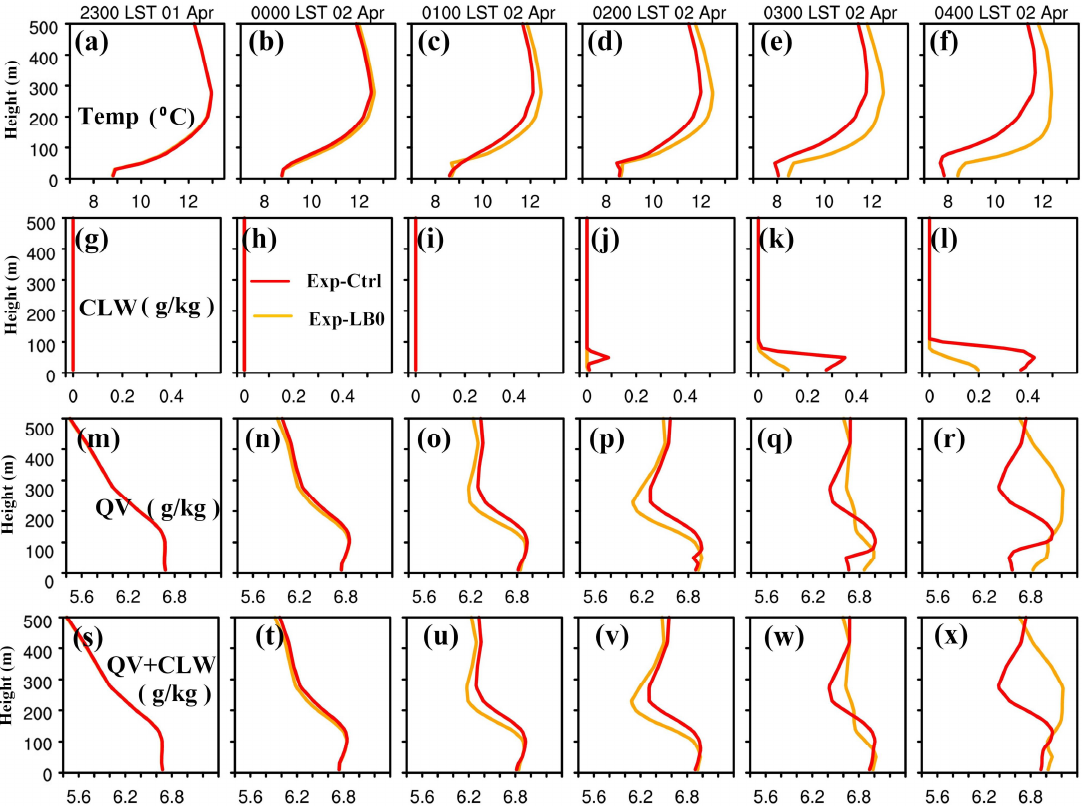
Figure 13. Vertical profiles of air temperature (Temp; ( a – f )), cloud liquid water (CLW; ( g – l )), water vapor (Qv; ( m – r )), and the sum of CLW and Qv (( s – x )) from 2300 LST 1 April to 0400 LST 2 April for Exp-Ctrl (red line) and Exp-LB0 (orange line), respectively. The profile location is marked by a red triangle in Figure 12.